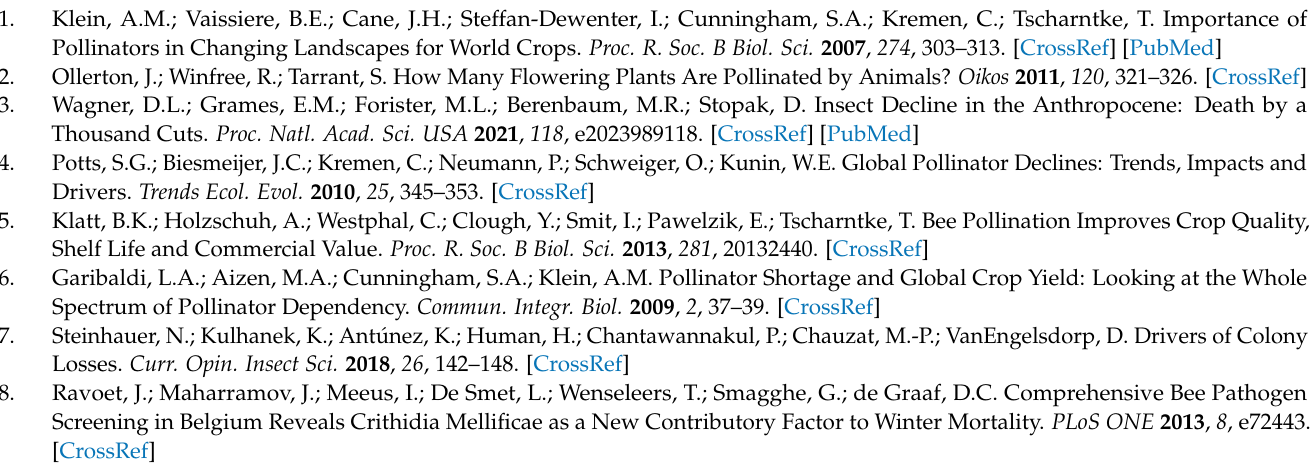
Table S1: List of Talaromyces compounds used for the metabolite